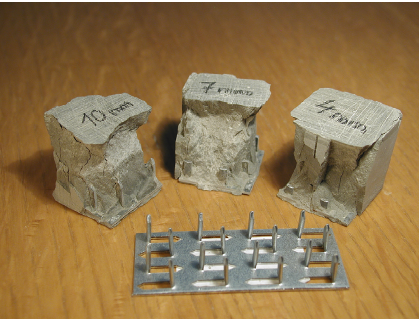
Figure 3: Hydrated cement paste specimens containing steel needles after the final destructive tests.